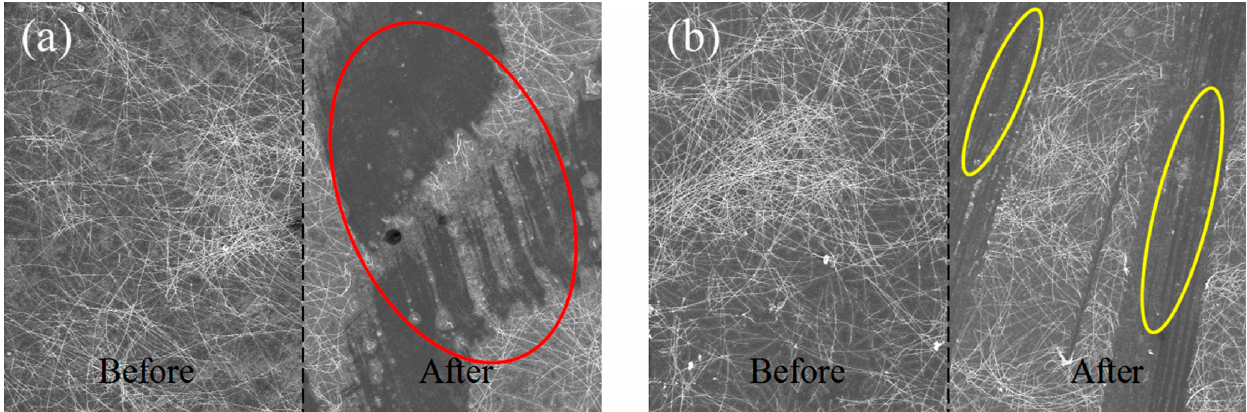
Figure 8. SEM pictures of adhesive test between AgNWs and substrate before and after moisture treatment: ( a ) SEM pictures of AgNWs-TCF surface before moisture treatment, ( b ) SEM pictures of AgNWs-TCF surface after moisture treatment.